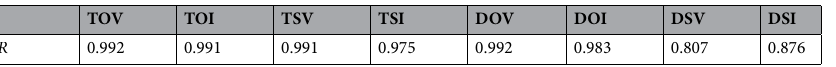
Table 10. Correlation coefficients between the predicted and the experimental fixation shift probabilities between AOIs for each experimental condition.